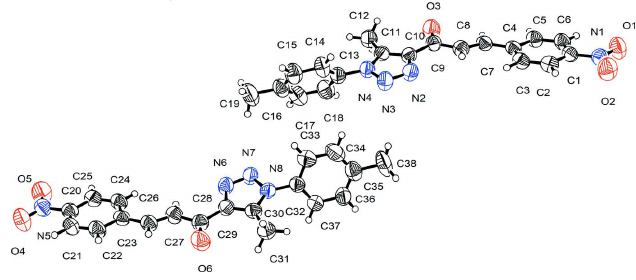
Table 1 Hydrogen-bond geometry (A˚ , (cid:2) ).